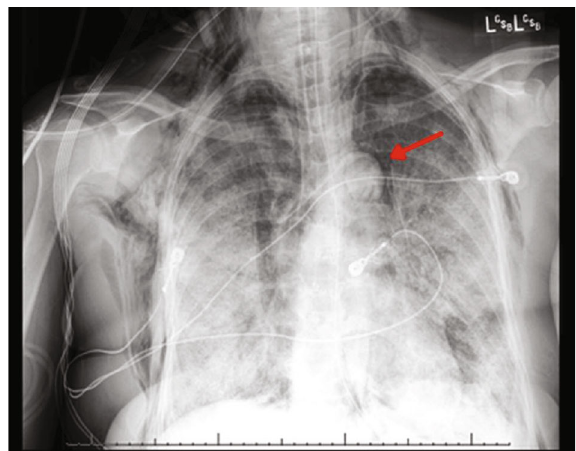
Figure 1: Chest X-ray AP portable shows bilateral progressive in fi ltrates, basal predominant, pneumomediastinum (red arrow), subcutaneous emphysema, and endotracheal tube in good position.